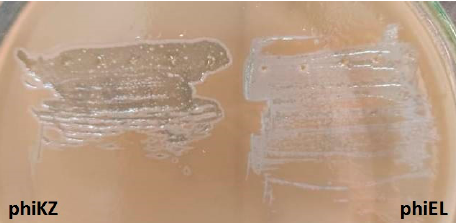
Figure 3. Examples of phiKZ-like phage growth on the lawn of P. aeruginosa PAO1 (different degrees of opalescence are visible).